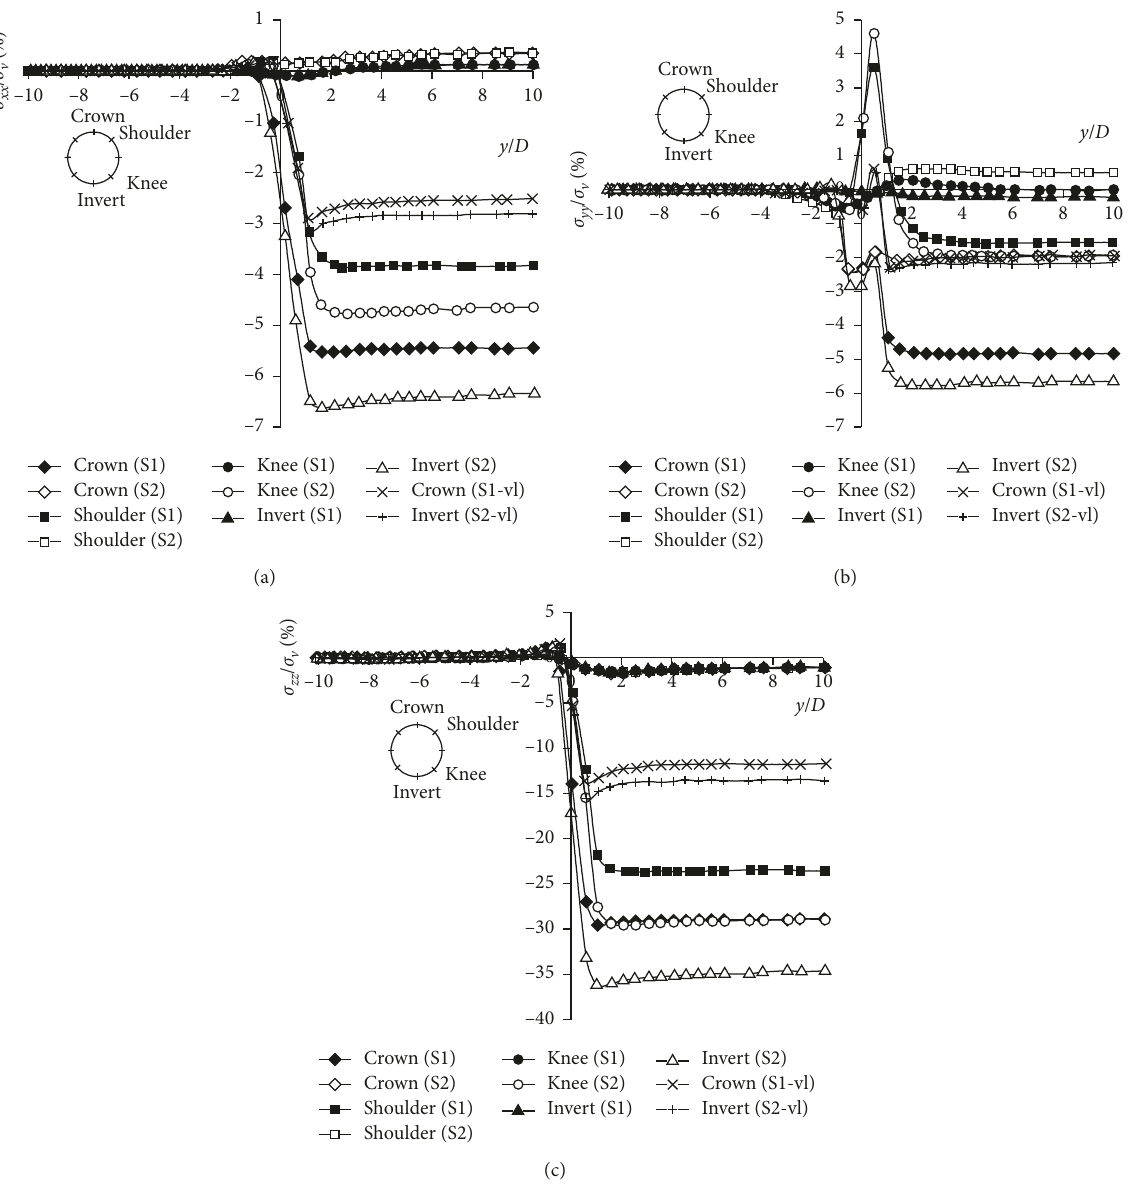
Figure 10: (a) Normalised longitudinal stress ratio, σ xx / σ v , (b) normalised transverse stress ratio, σ yy / σ v , and (c) normalised vertical stress ratio, σ zz / σ v , around the existing tunnel as tunnel face